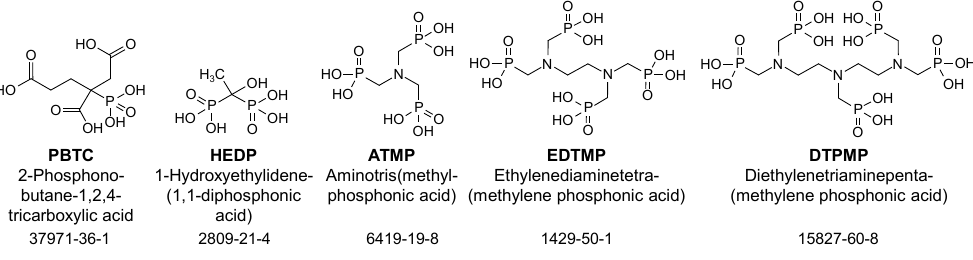
Figure 1. Overview of the phosphonates investigated in this study with their CAS numbers.